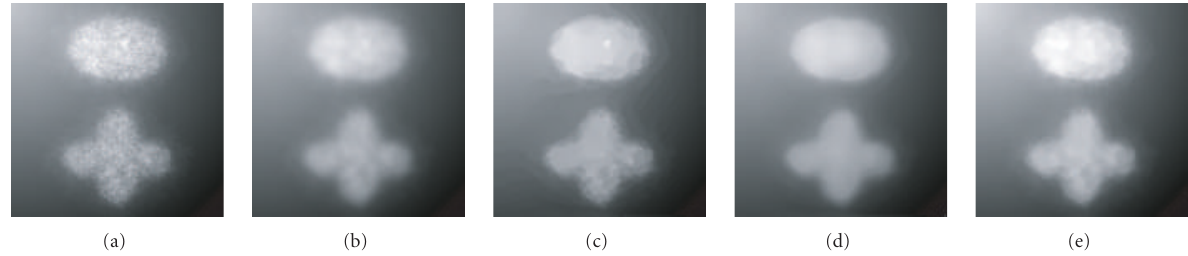
Figure 1: Denoising e ff ect comparison among GNF, SRAD, and GNF plus SRAD: (a) original image; (b) filtering result of GNF; (c) filtering result of SRAD; (d) filtering result of GNF plus SRAD; (e) filtering result of anisotropic median-di ff usion (MAD)